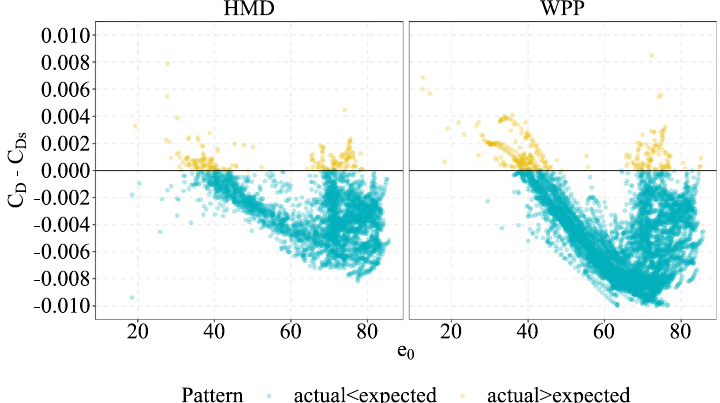
Fig. 2 The sensitivity of crude death rate ( C D — C Ds ) and life expectancy at birth ( e 0 ) in countries from HMD and WPP